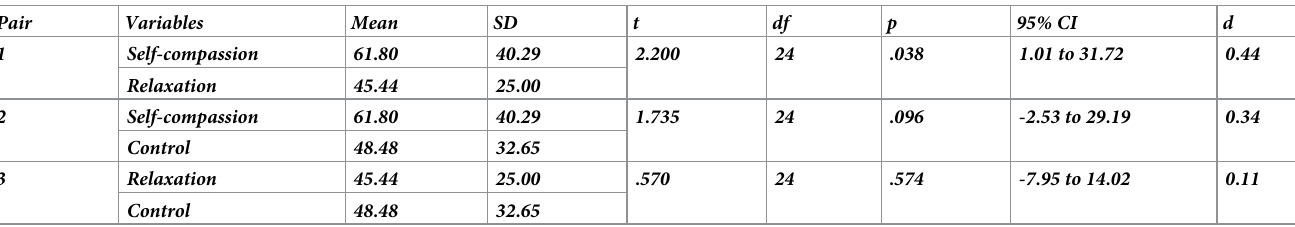
Table 1. T-tests comparing RMSSD during three